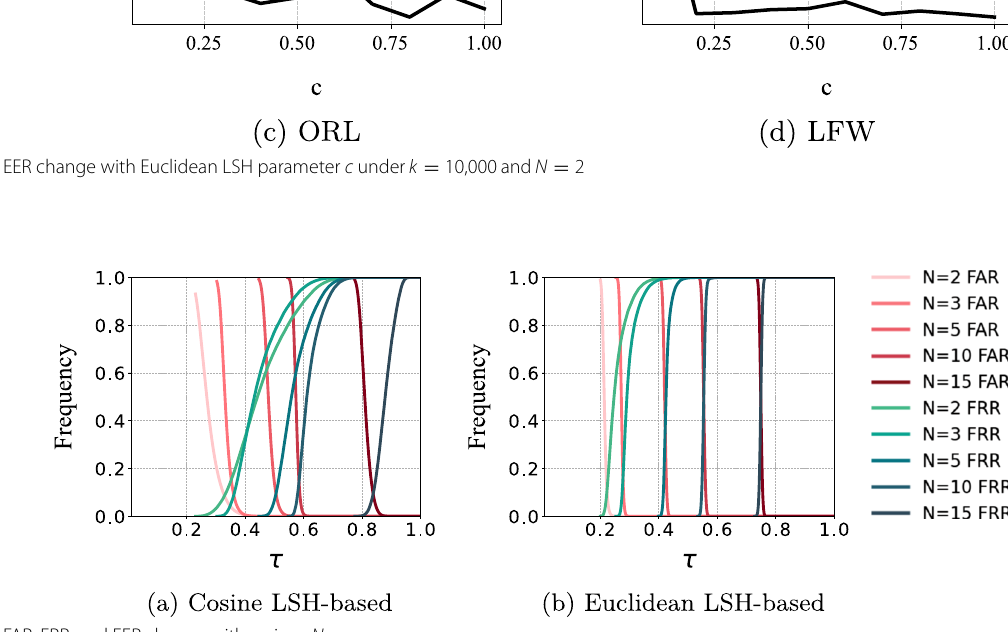
Fig. 6 FAR, FRR, and EER change with various